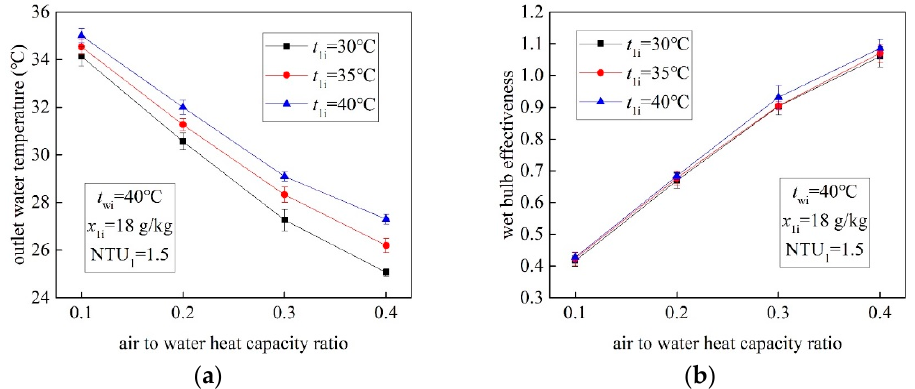
Figure 10. Impact of the heat capacity ratio between air and water on the performance of the MCT: ( a ) w 1 / w w vs. t wo ; ( b ) w 1 / w w vs. ε WB .